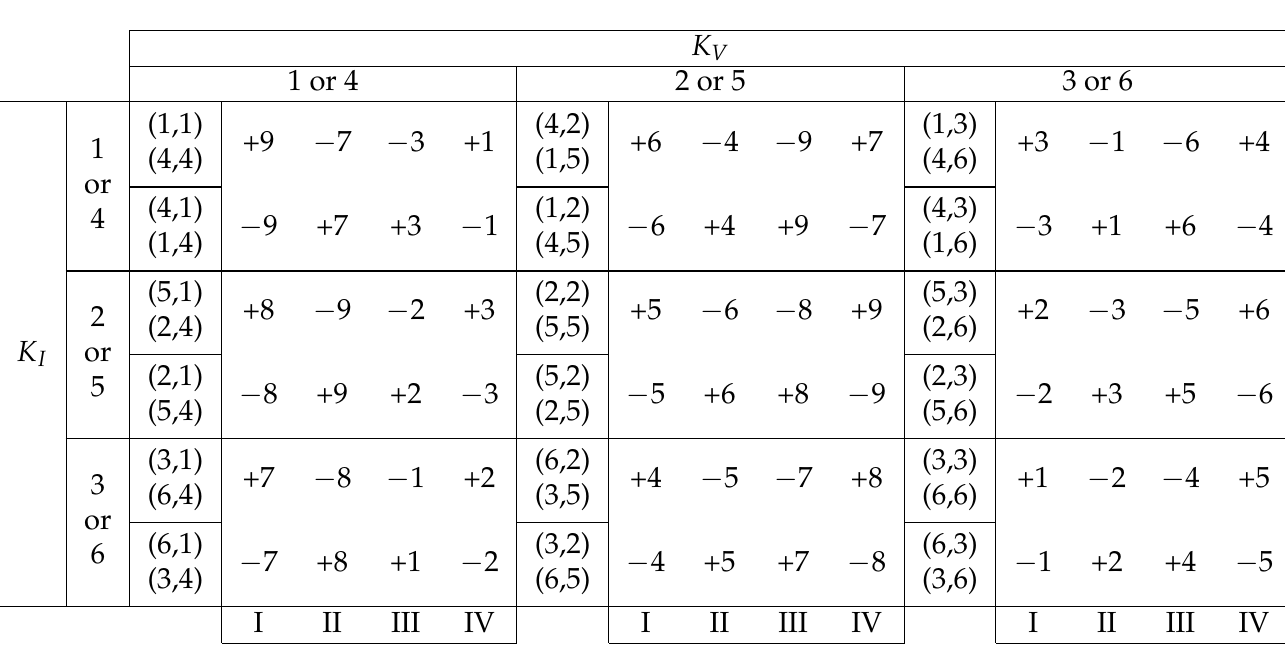
Figure 8. Selection of switching arrangements for each set of K V and K I